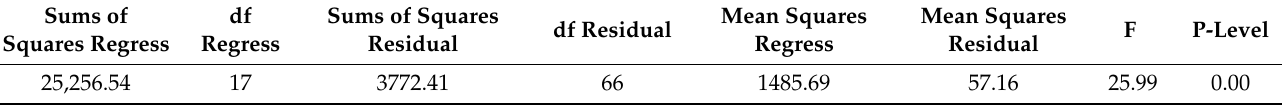
Table 8. Results of ANOVA for regression model.